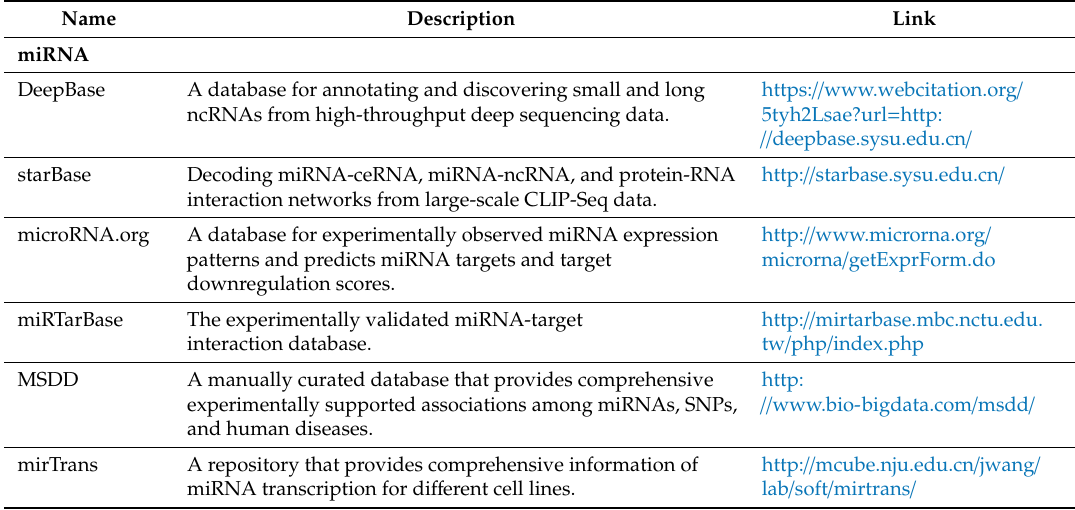
Table 3. An overview of main human disease-associated ncRNA